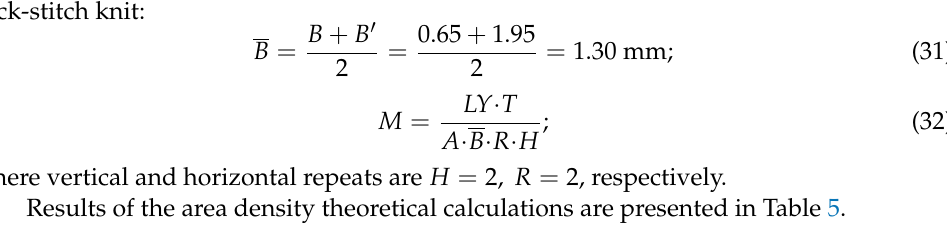
Table 5. Area density and relative error between the theoretically calculated and experimentally measured values. Pattern Theoretically Calculated Area Density M, g/m 2